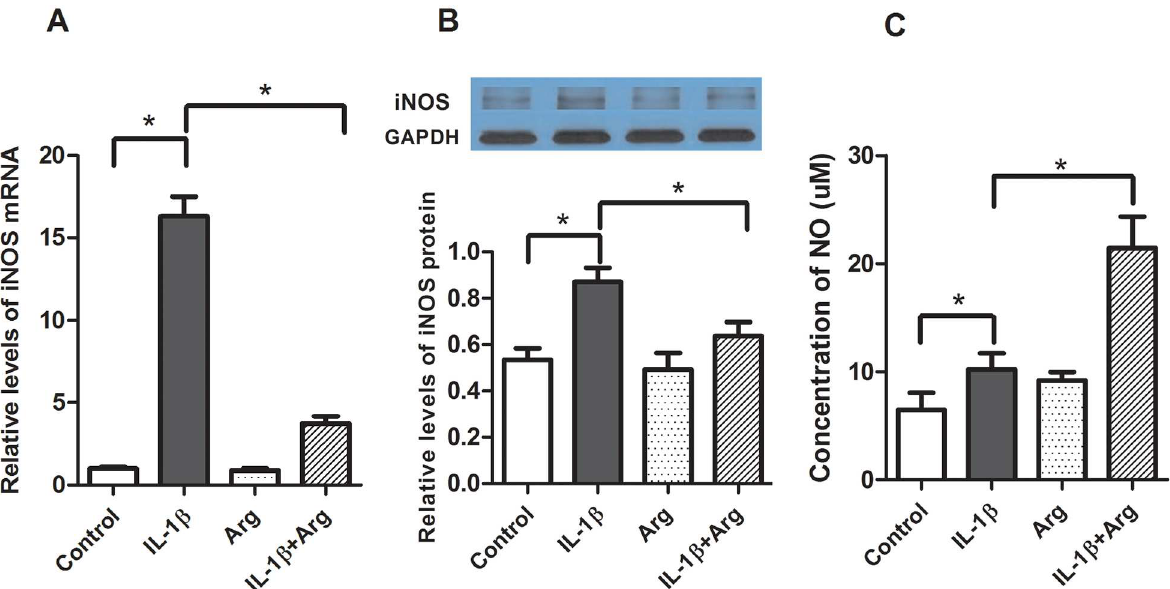
Fig 7. Effects of L-Arg and IL-1 β on iNOS expression. Caco-2 cells were treated with IL-1 β (4 ng/ml) for 4 hours after an incubation of L-Arg (5 mM) for 4 hours (Fresh medium with L-Arg was appliedafter removing medium). Cells were harvested for the isolationof total RNA and protein. A: iNOS mRNA was determinedby qRT-PCR and normalized to β -actin. B: iNOS protein was measuredby Western blot analysisnormalizedto β -actinC: NO levels in cell culture media were measuredas describedin Methods. Data are means ± SE, * P < 0.05.(n = 6